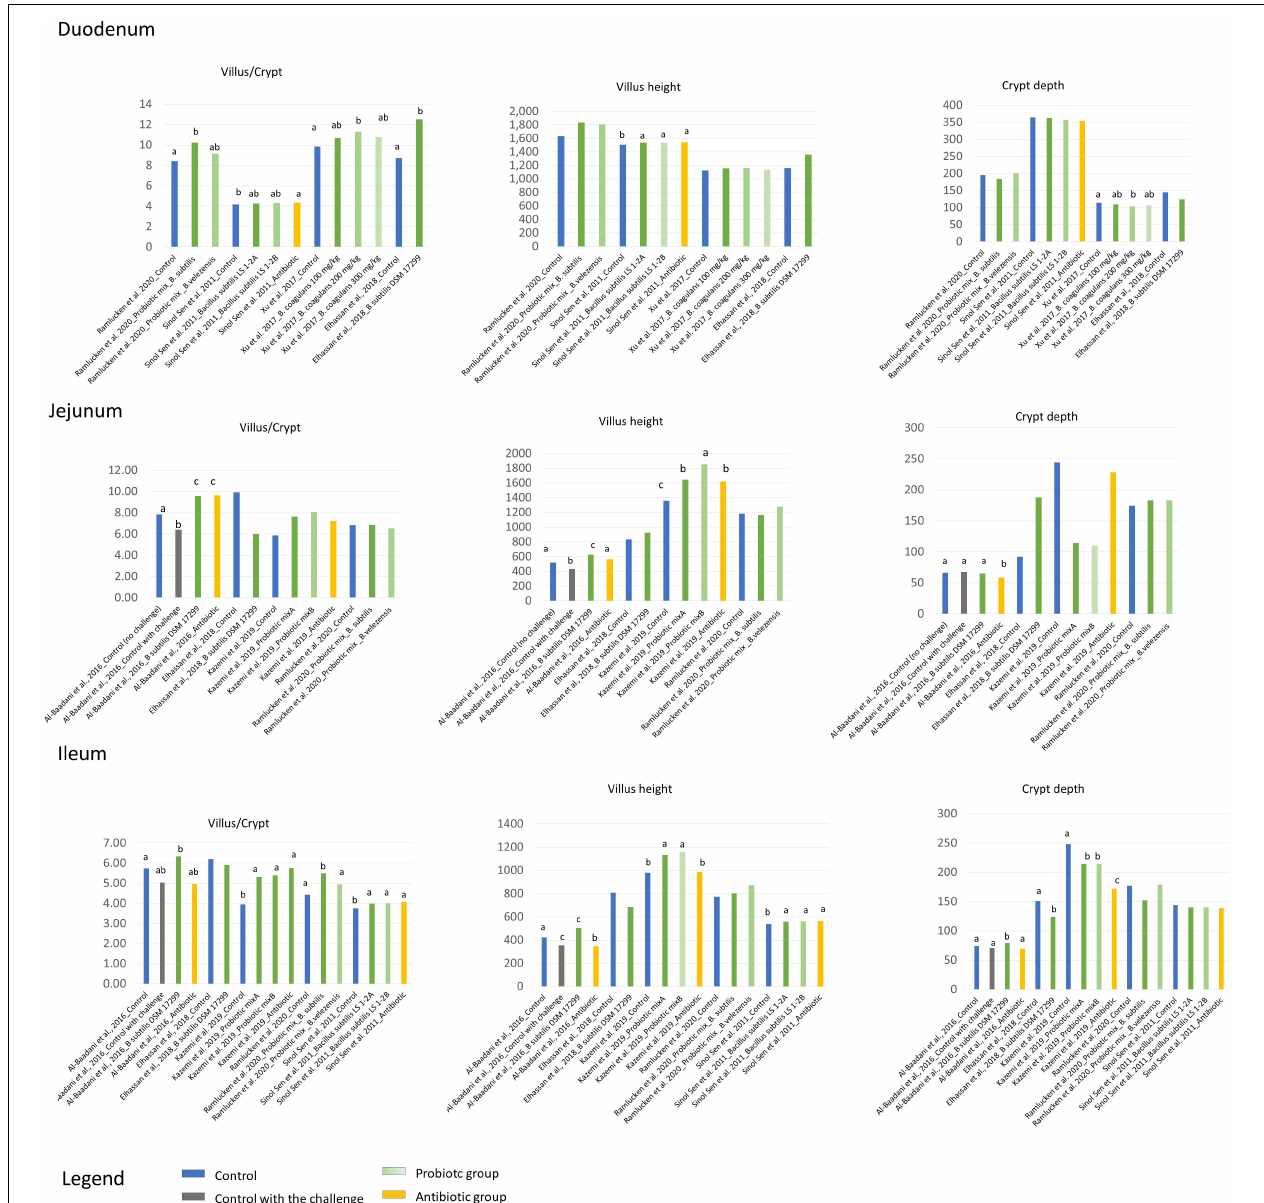
FIGURE 3 | The effect of Bacillus probiotics on the villus/crypt ratio, villus height and crypt depth in the duodenum, jejunum and ileum of broilers as compared with no probiotic or antibiotic supplementation. The letters represent significant differences among the groups within the